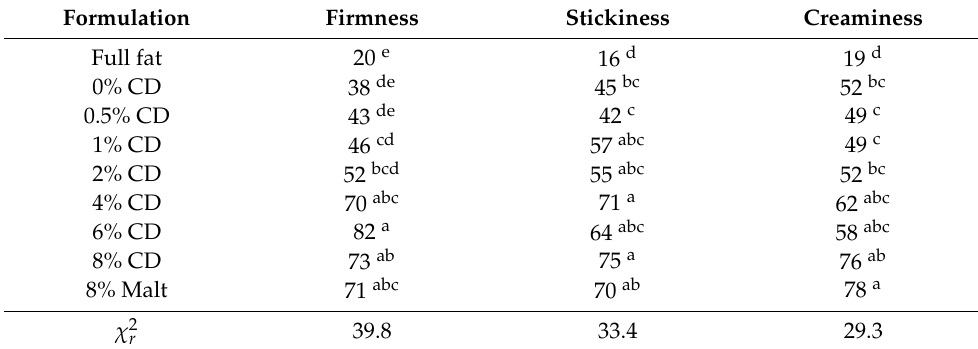
Table 4. Rank sum scores for the sensory attributes of firmness, stickiness, and creaminess and the critical χ 2 r